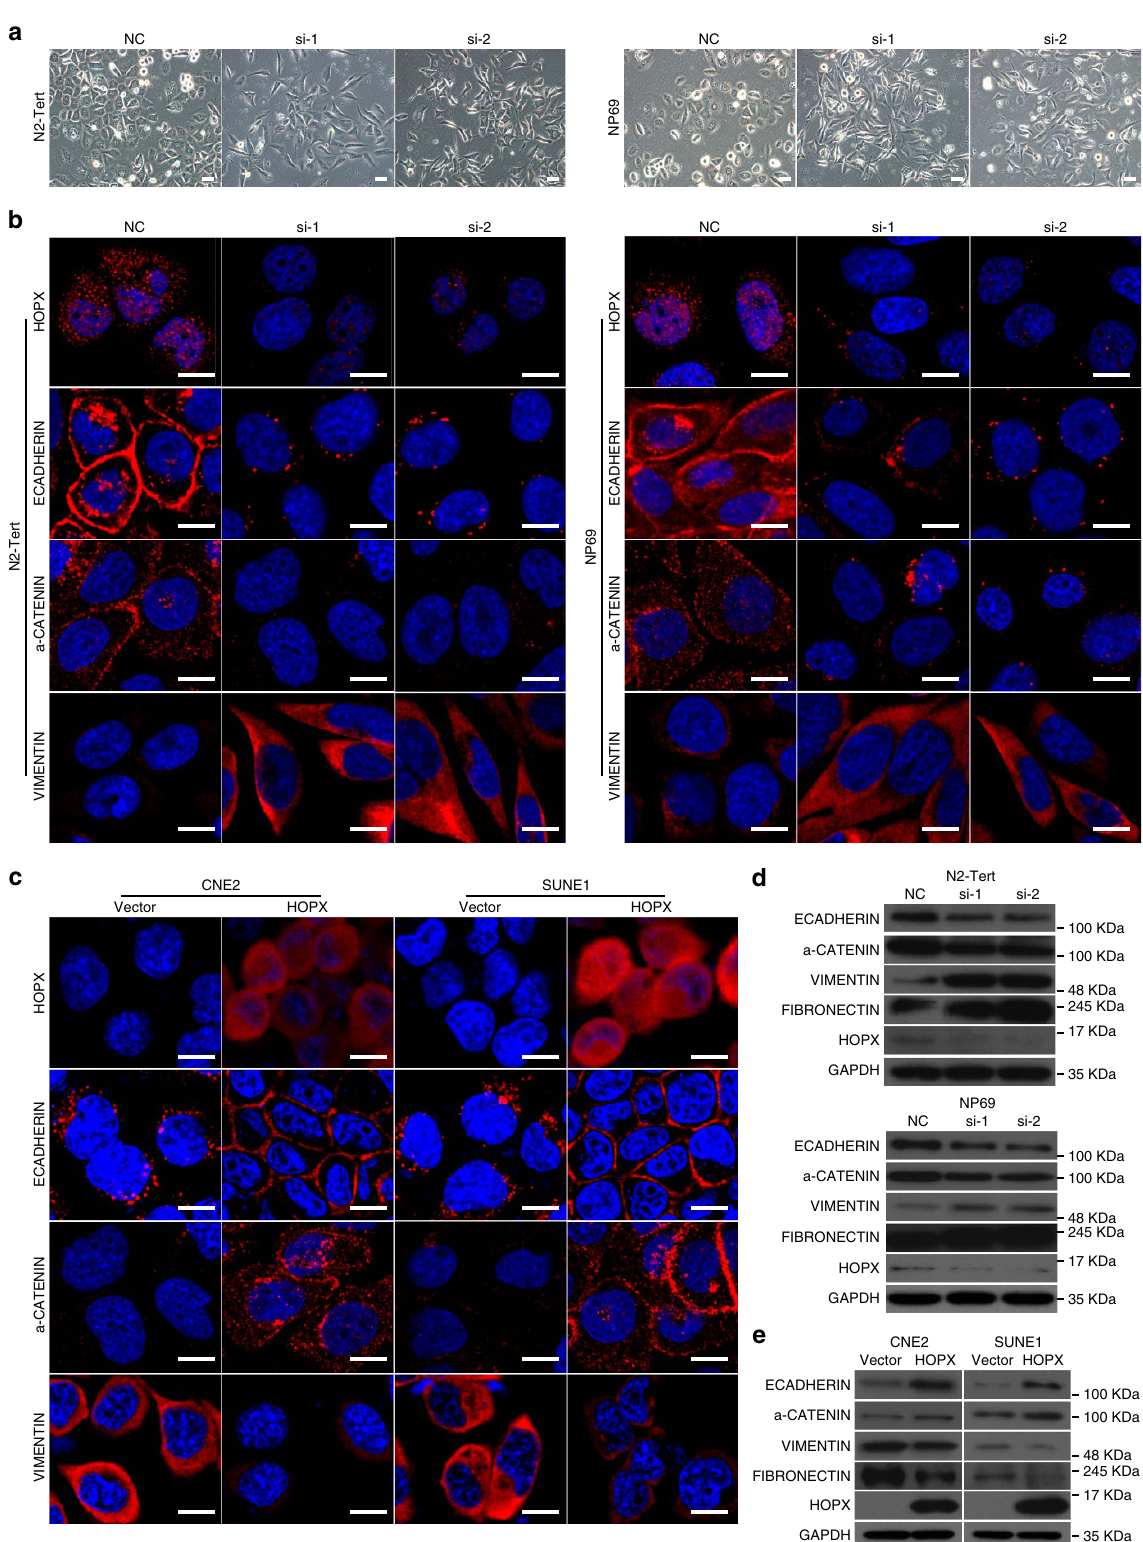
Figure 4 | HOPX partially suppresses EMT in NPC cells. ( a ) Phase contrast images ( (cid:2) 200) of N2-Tert and NP69 cells expressing control NC or HOPX -siRNAs (si-1 and si-2). Scale bar, 100 m m. ( b , c ) Immunofluorescence images ( (cid:2) 600) for HOPX, ECADHERIN, a -CATENIN and VIMENTIN expression in N2-Tert and NP69 cells transiently expressing control NC or HOPX -siRNAs (si-1 and si-2) ( b ), and CNE2 and SUNE1 cells stably overexpressed the vector or HOPX ( c ). Scale bar, 100 m m. ( d , e ) Western blotting analysis of ECADHERIN, a -CADHERIN, VIMENTIN, FIBRONECTIN, HOPX and GAPDH expression in N2-Tert and NP69 cells transfected with the control NC or HOPX -siRNAs ( d ), and CNE2 and SUNE1 cells stably overexpressed the vector or HOPX ( e ). These data are representative of three independent